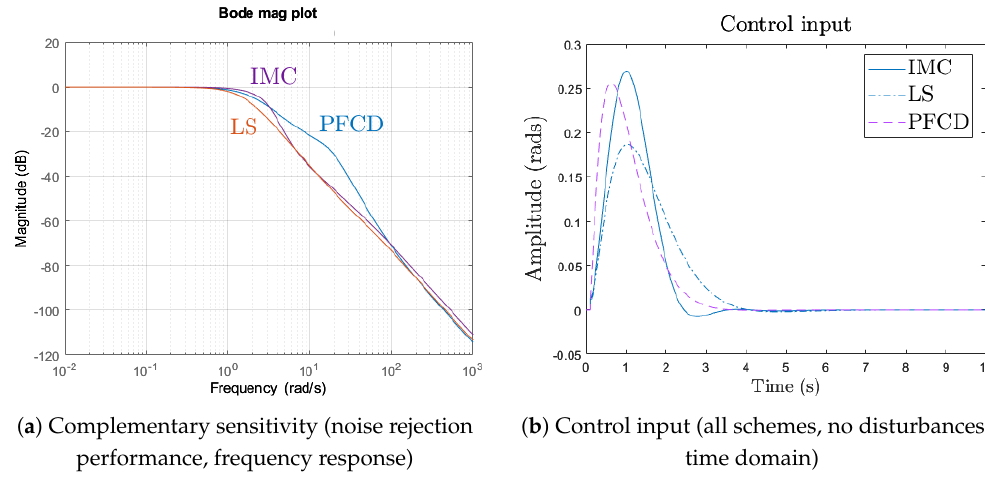
Figure 18. IMC–i controller (frequency response).